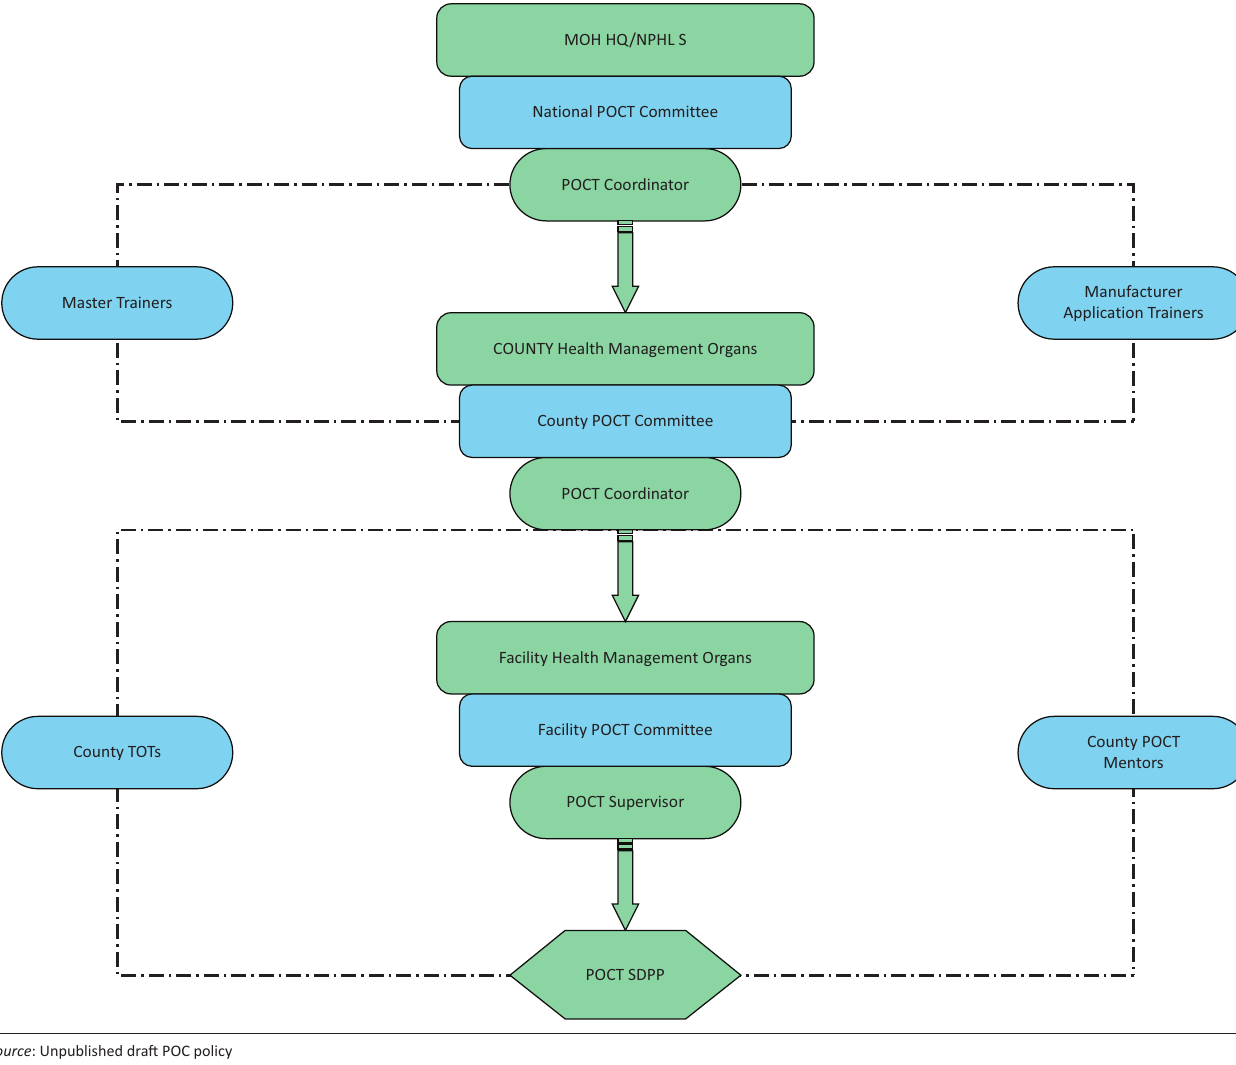
FIGURE 1: Kenya point-of-care quality assurance programme management